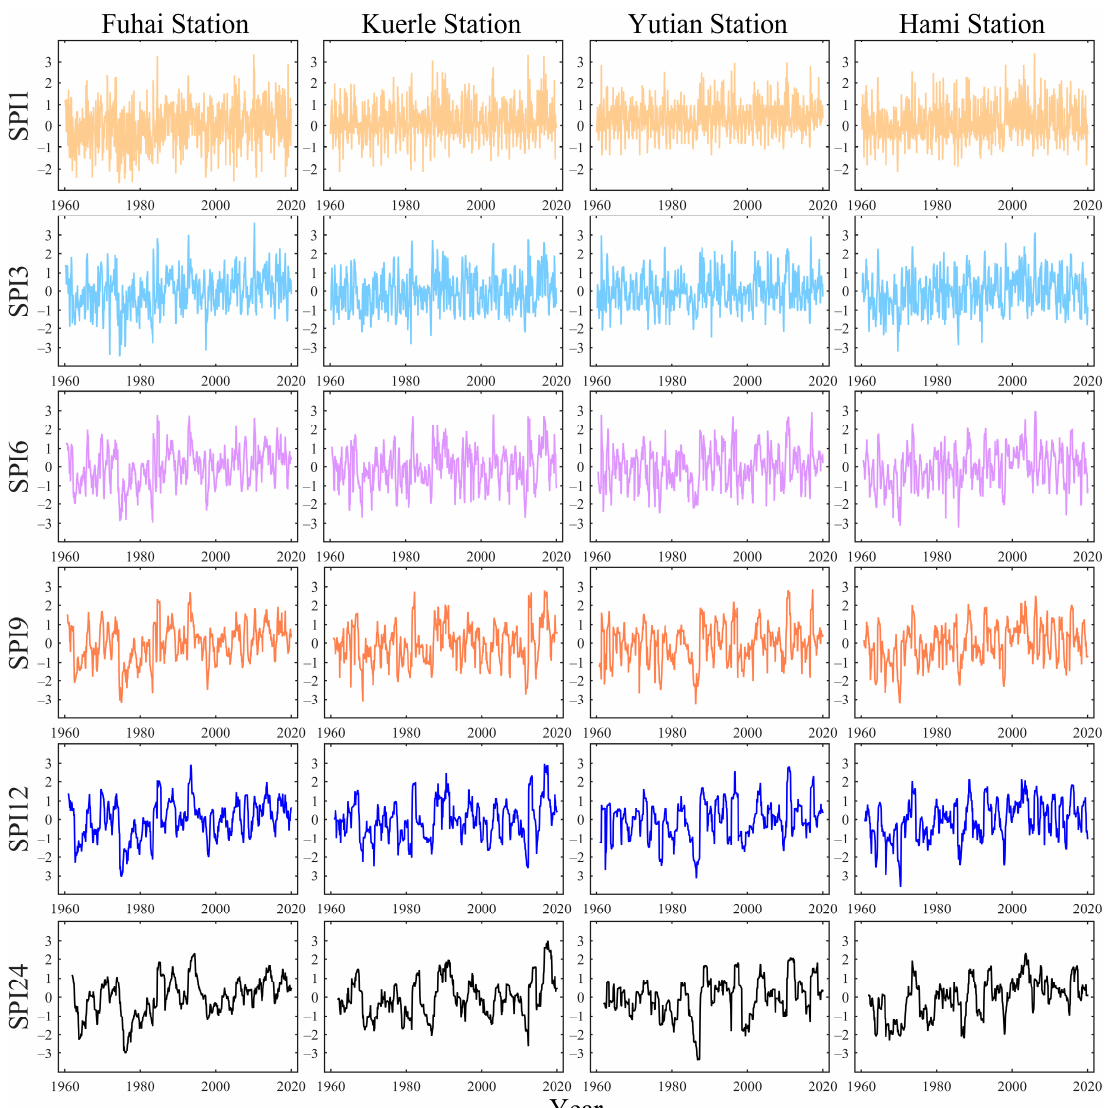
Figure 4. Observed SPI values at the 1-, 3-, 6-, 9-, 12-, and 24-month timescales of the example stations.